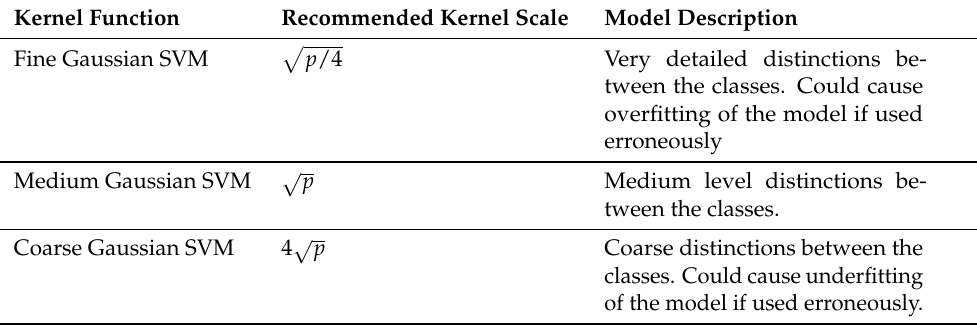
Table 2. Comparison of three SVM Gaussian kernels used in our studies Kernel Function Recommended Kernel Scale Model Description (cid:112) p /4 Very detailed distinctions be- Fine Gaussian SVM tween the classes. Could cause overfitting of the model if used erroneously √ p Medium level distinctions be- Medium Gaussian SVM tween the classes. √ p Coarse distinctions between the Coarse Gaussian SVM 4 classes. Could cause underfitting of the model if used